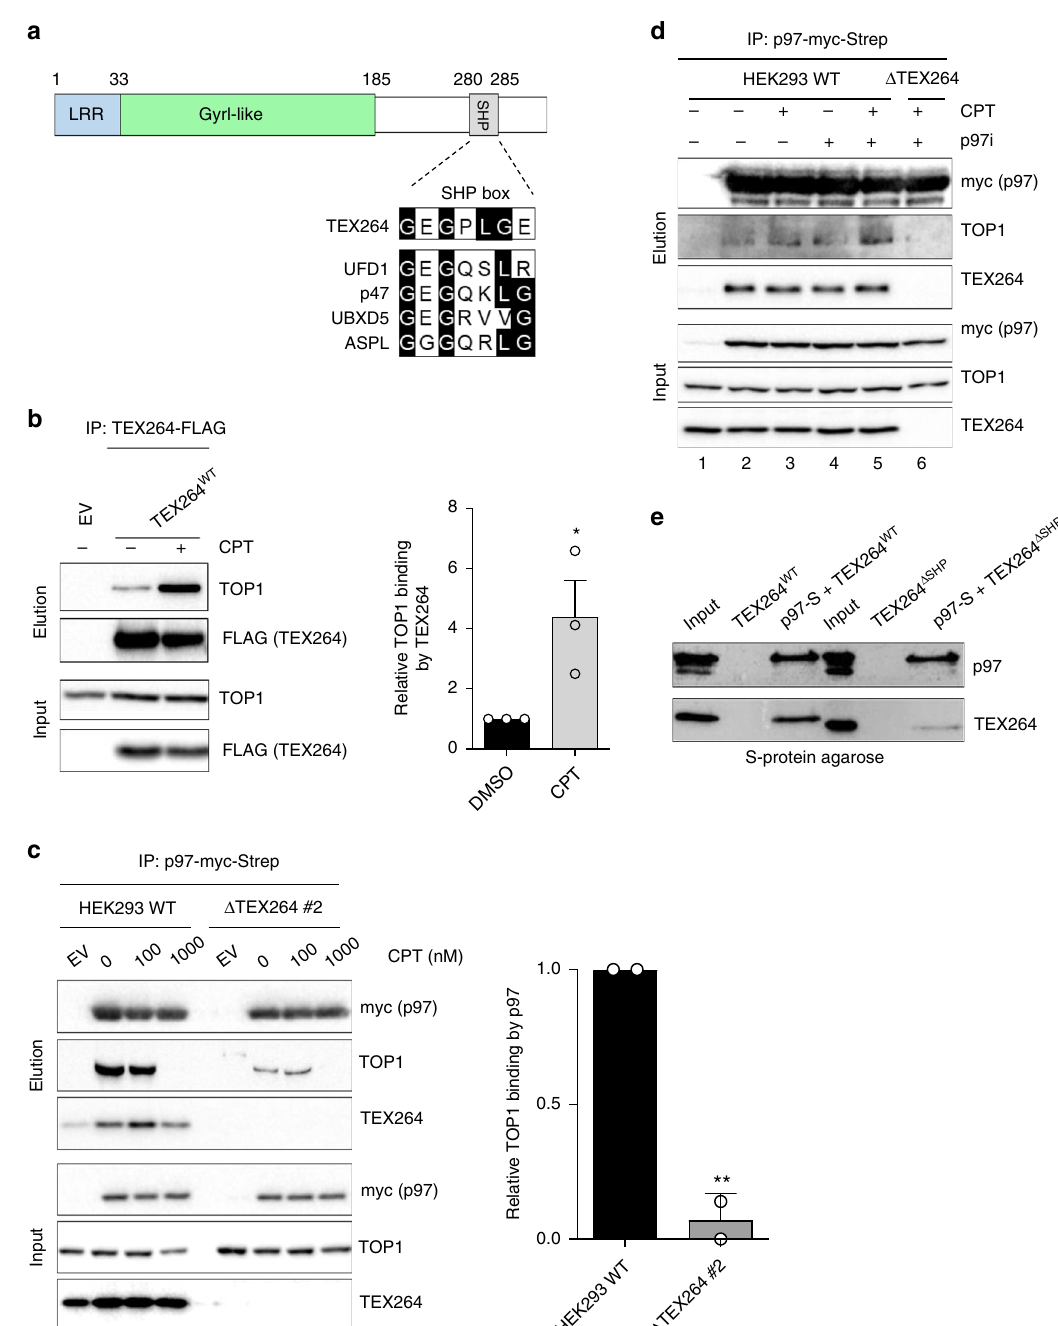
Fig. 2 TEX264 bridges p97 to TOP1. a Above: schematic diagram of the TEX264 protein. LRR denotes leucine-rich repeat; GyrI-like, Gyrase inhibitory-like domain; SHP, SHP box. Below: sequence alignment of TEX264 280 – 286 with the SHP box of other p97 cofactors. Conserved residues are highlighted in black. b FLAG immunoprecipitates prepared from HEK293 cells transiently expressing TEX264 WT -FLAG cDNA or EV, treated with CPT (25 nM) or DMSO for 1 h. Right: quanti fi cation of three independent experiments (error bars represent mean ± SEM; ** P < 0.01; Student ’ s t -test). c Immunoblots of